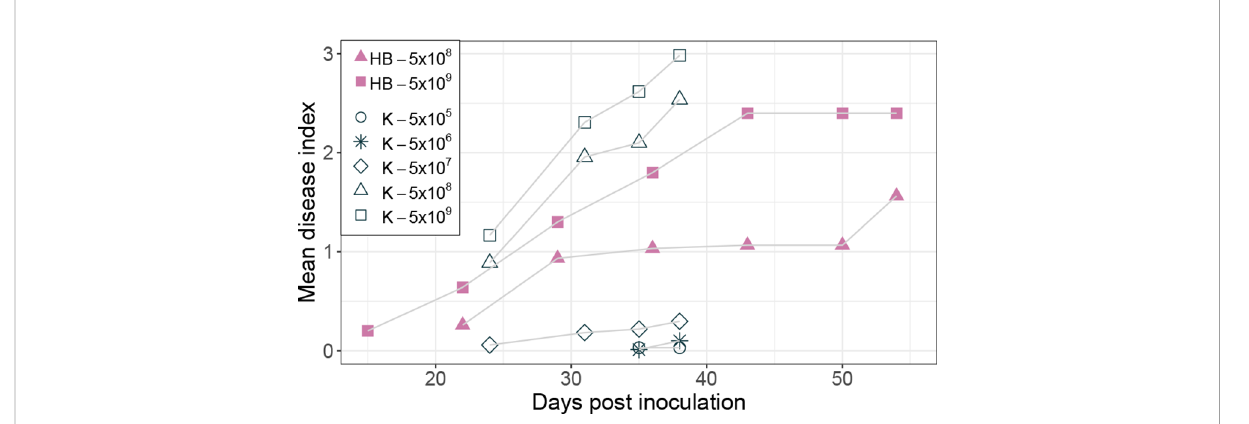
FIGURE 2 Development of bacterial wilt disease of potato plants cv Kondor (K, open black symbols) and HB ( fi lled purple symbols) in greenhouse experiments inoculated with different doses of Ralstonia solanacearum in CFU, as indicated in the legend. The mean disease index was assessed by scoring the wilting symptoms of stems on a scale from 0 (no wilt) – 4 (100% wilted). The score of no wilt (0) is not displayed in the